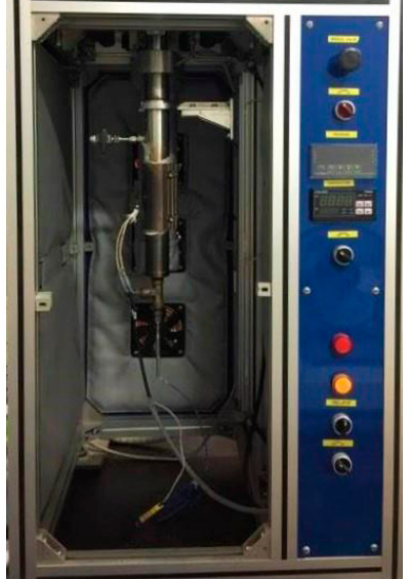
Figure 5. Micro-balance Thermo D-200.